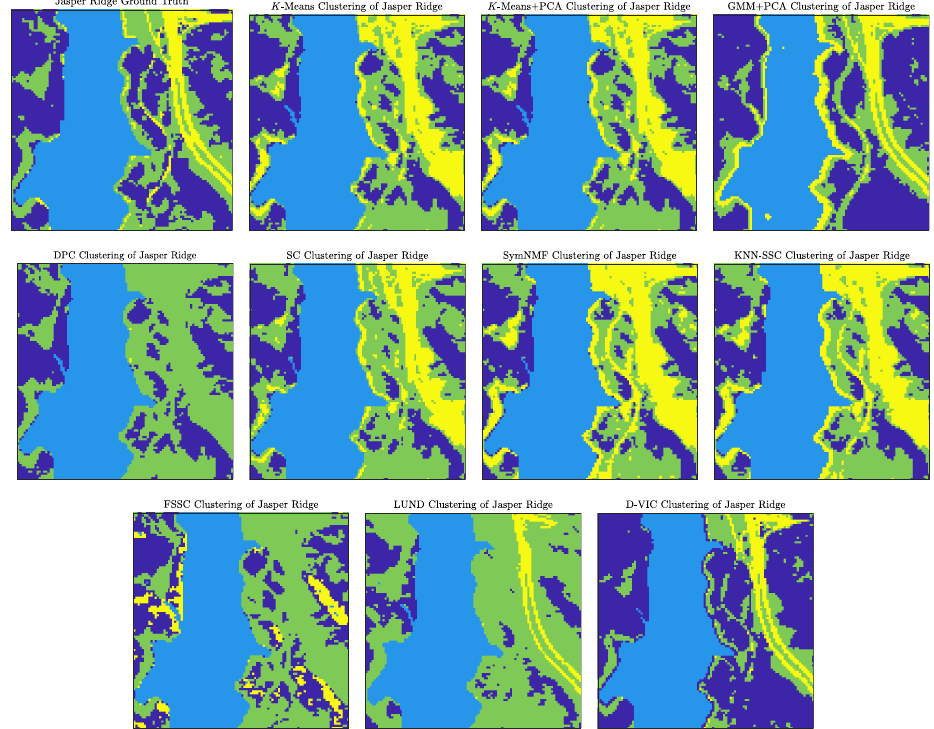
Figure 7. Comparison of clusterings produced by D-VIC and related algorithms on the Jasper Ridge HSI. D-VIC outperforms all other algorithms, largely due to superior performance among pixels corresponding to tree and soil classes (indicated in dark blue and green,